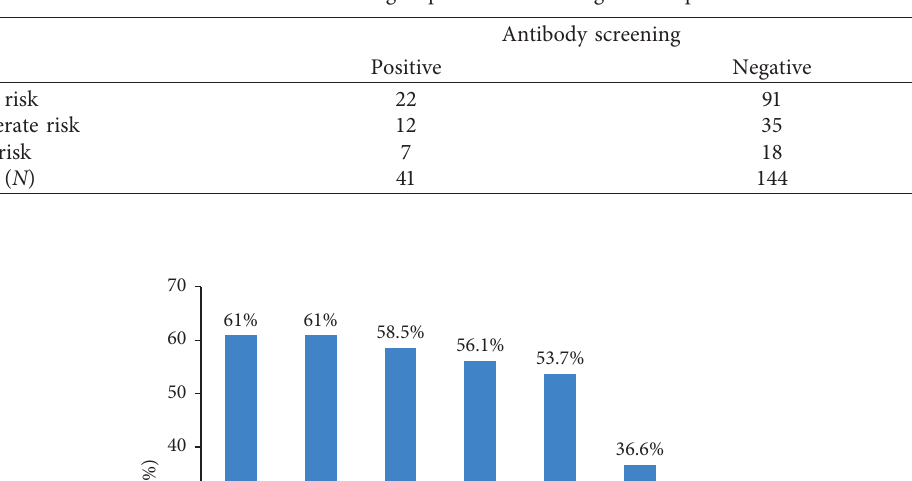
Table 2: Risk group based on the degree of exposure to COVID-19.